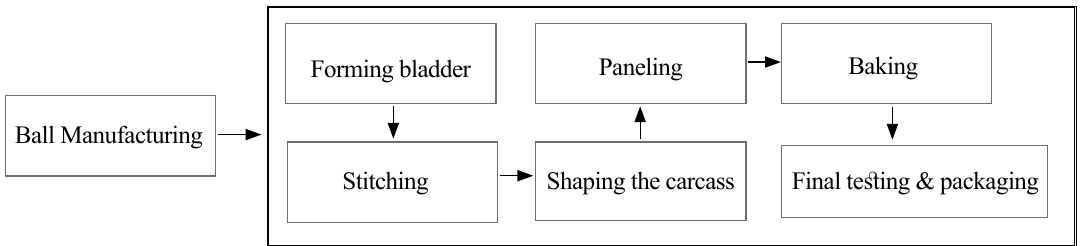
Figure 1. System boundary for LCA of ball manufacturing using bladder with natural rubber and bladder with recycled+natural